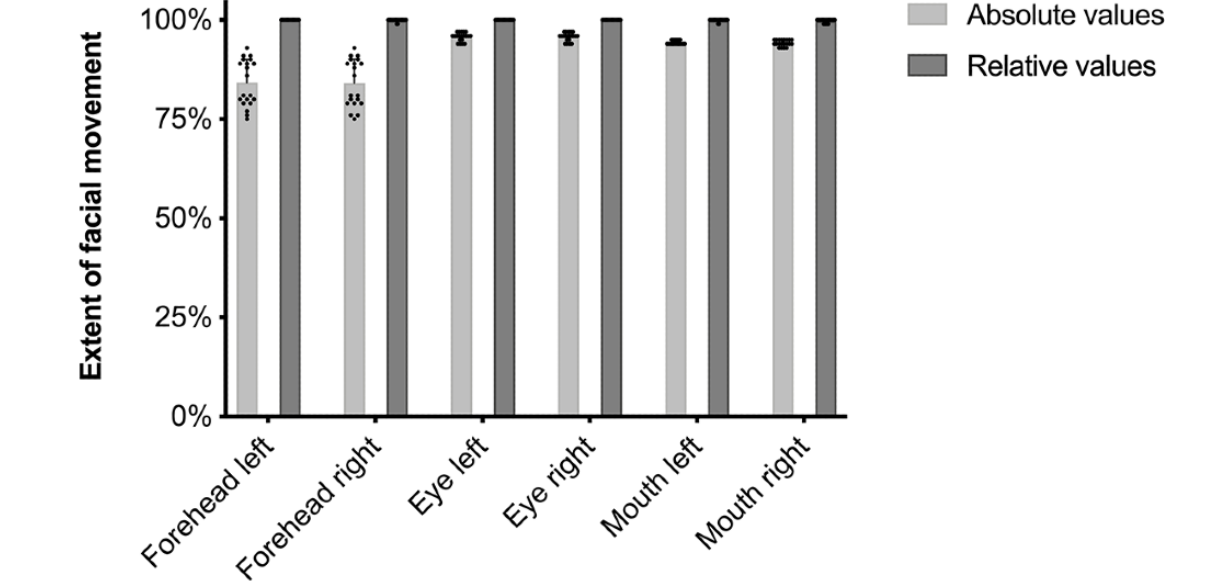
Figure 6. Intertest variability and SD (bars) of measurements with the app prototype and 4 healthy subjects (10 measurements each); no asymmetry of facial motor skills was found.